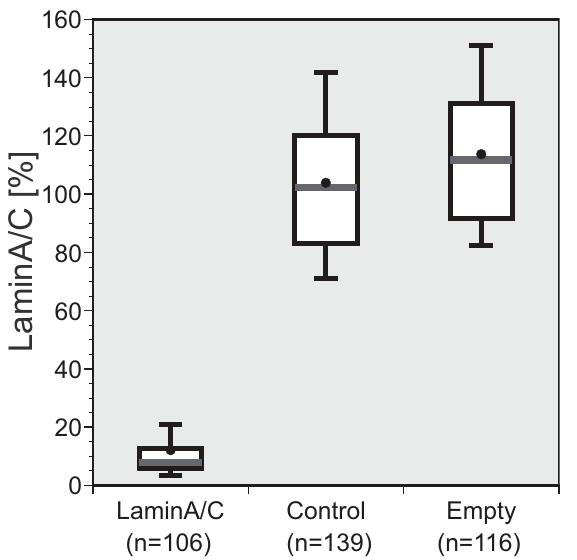
Supplemental Figure 9. Quantification of laminA/C by immunofluorescence. Immunofluorescence-based quantification of laminA/C was checked for specificity with two different negative controls. The results in our previous work 13 are presented by box plots of the lamin A/C levels [%] of untransfected HeLa cells. The top, bottom, and line through the middle of the box correspond to the 75th percentile (top quartile), 25th percentile (bottom quartile), and 50th percentile (median) respectively. The whiskers indicate the 10th percentile and 90th percentiles. The closed circle represents the mean. HeLa cells were transfected with pG-SUPER-hLaminA/C (LaminA/C), -mFascin1 (control) and empty vector not expressing shRNA (empty). pG-SUPER is almost identical to pSHIN-G except that the human H1 RNA promoter sequence is longer (215 nt rather than 91 nt) and works similarly to pSHIN-G. Six days after transfection, cells were immunostained and analyzed as described